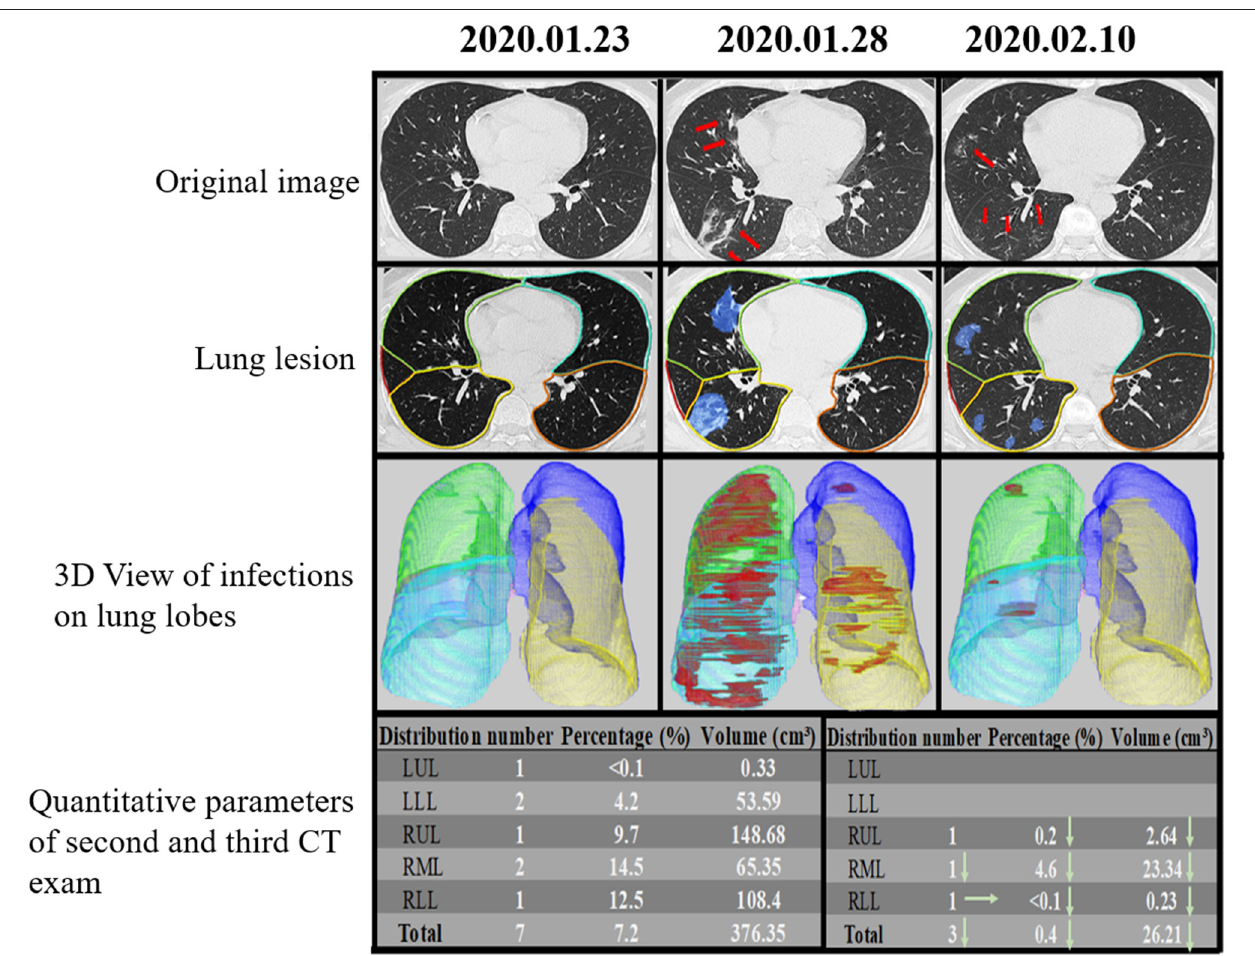
FIGURE 5 | Temporal lung changes of a confirmed case in the non-ICU group on thin Slice CT. A 48-year-old man who was confirmed with COVID-19 pneumonia after fevered for 2 days. He was discharged after 18 days of treatment without ICU admission. Original image at three-time points (dates annotated above each panel) showed no abnormality at the first time, GGOs, and consolidations appear 6 days later, and lesions gradually absorbed 17 days later, only leaving some ill-defined GGOs. Lung lesion images were AI assist system at the same level and time points, showing the infection area in blue. 3D View of Infections on Lung Lobes was three-dimensional volume-rendered reconstructions at the same time points as in original green, RML in pink, RLL in blue. The quantitative parameters table showed the lesion percentage and volume in each lobe on the second and third scan. LUL, left upper lobe; LLL, left lower lobe; RUL, right upper lobe; RML, right middle lobe; RLL, right lower